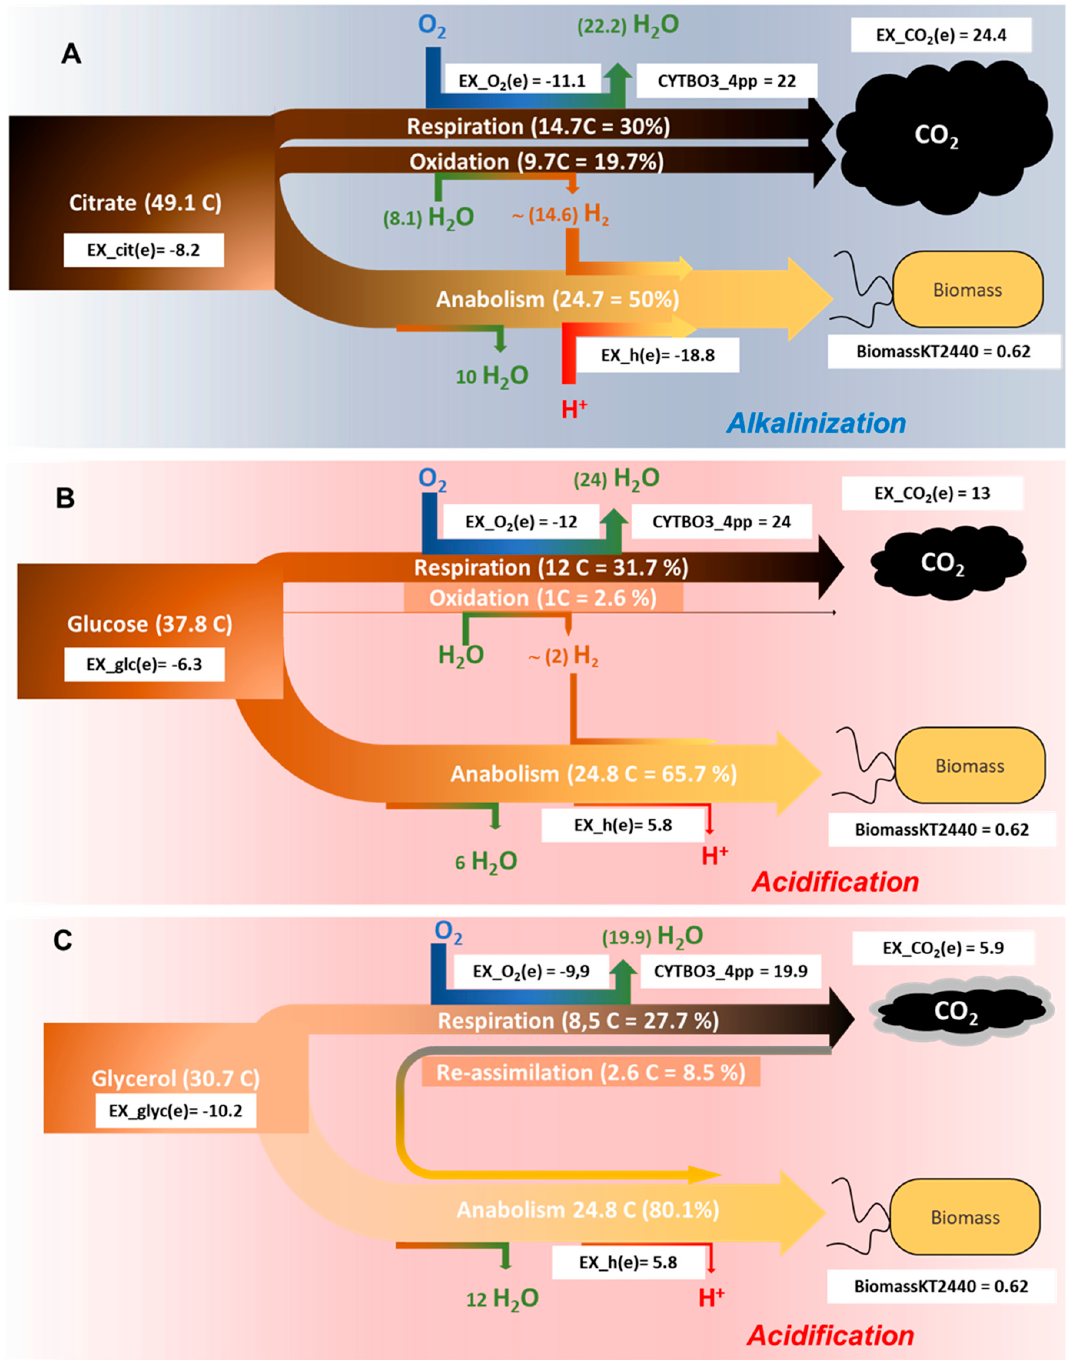
Figure 5. Carbon-flow distribution in P. putida 2440 (iJN1411) as a function of the carbon source. Cell growth (biomassKT2440) was normalized as indicated in M&M. The white rectangles represent the normalized flow through the indicated reactions. The total amount of citrate ( A ), glucose ( B ), or glycerol ( C ) is divided into two main streams, one rendering biomass (anabolism, lower part of each scheme) or CO 2 (catabolism, upper part). The percentage and number of carbons through respiration was calculated from the consumed O 2 (ex_o2(e)) according to Table 1. The difference between the produced CO 2 (ex_co2(e)) and that expected from respiration (Table 1) is re-assimilated in the case of glycerol ( C ) or oxidized according to Table 2, rendering reducing power. CYBO3_4pp: Cytochrome c oxidases, bo3 -type).